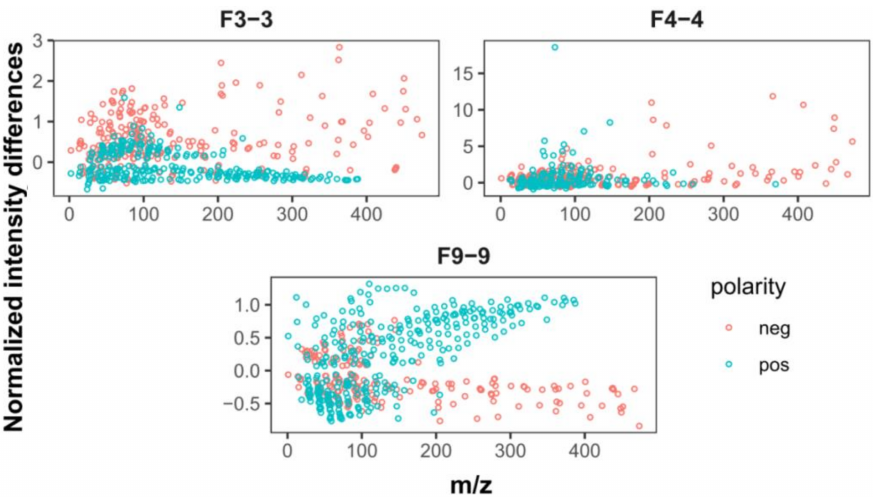
Figure 3. Differences in the mean of normalized intensities for exposed (FX) and non-exposed (X) samples to fulvic acids (FX-X: F3-3, F4-4, and F9-9) averaged over 36 replicates. Red dots depict negatively charged ions, and blue dots depict positively charged ions measured by